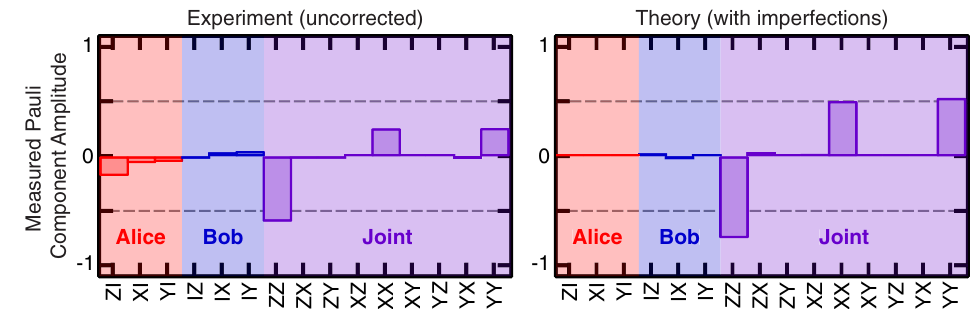
FIG. 4. Entanglement characterization. Left: Experimentally measured Pauli vector components of the two-qubit entangled state confirming that the final state is the odd Bell state ð 1 = Pauli components accounting for qubit decoherence, detector dark counts, and tomography